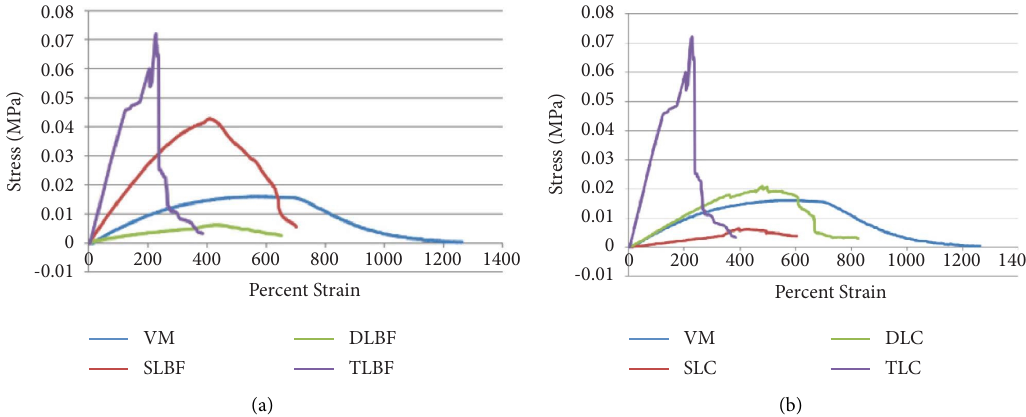
Figure 13: Comparative study of fexural properties (a) with diferent layers of silk fbre (b) with diferent layer of silk